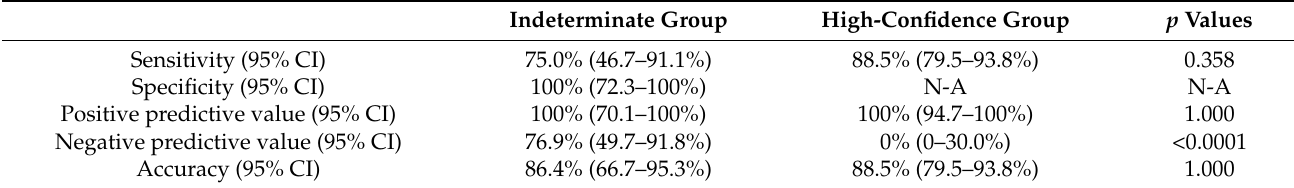
Figure 2. A 79-year-old female patient with multiple enlarged lymph nodes (patient no. 16). ( a ) CT scan showed multiple enlarged lymph nodes (arrow) in retroperitoneal spaces. The differential diagnosis was tuberculosis versus metastasis from other cancer. ( b ) EUS-guided sampling was performed. ( c ) Gross examination of aspirated material showed whitish granular material with blood. ( d ) Cytologic examination demonstrated necrotic background, multinucleated giant cell (arrow), and granuloma (×400, Papanicolaou stain). Polymerase chain reaction for tuberculosis was also positive. Table 2. Diagnostic performance to differentiate malignant and benign lesions between indeterminate radiological diagnosis group and high-confidence radiological diagnosis